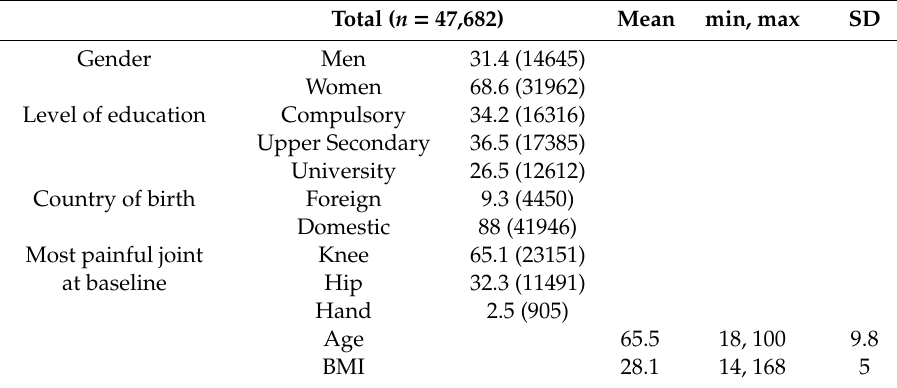
Table A2. Sociodemographic distribution of excluded cases over featured